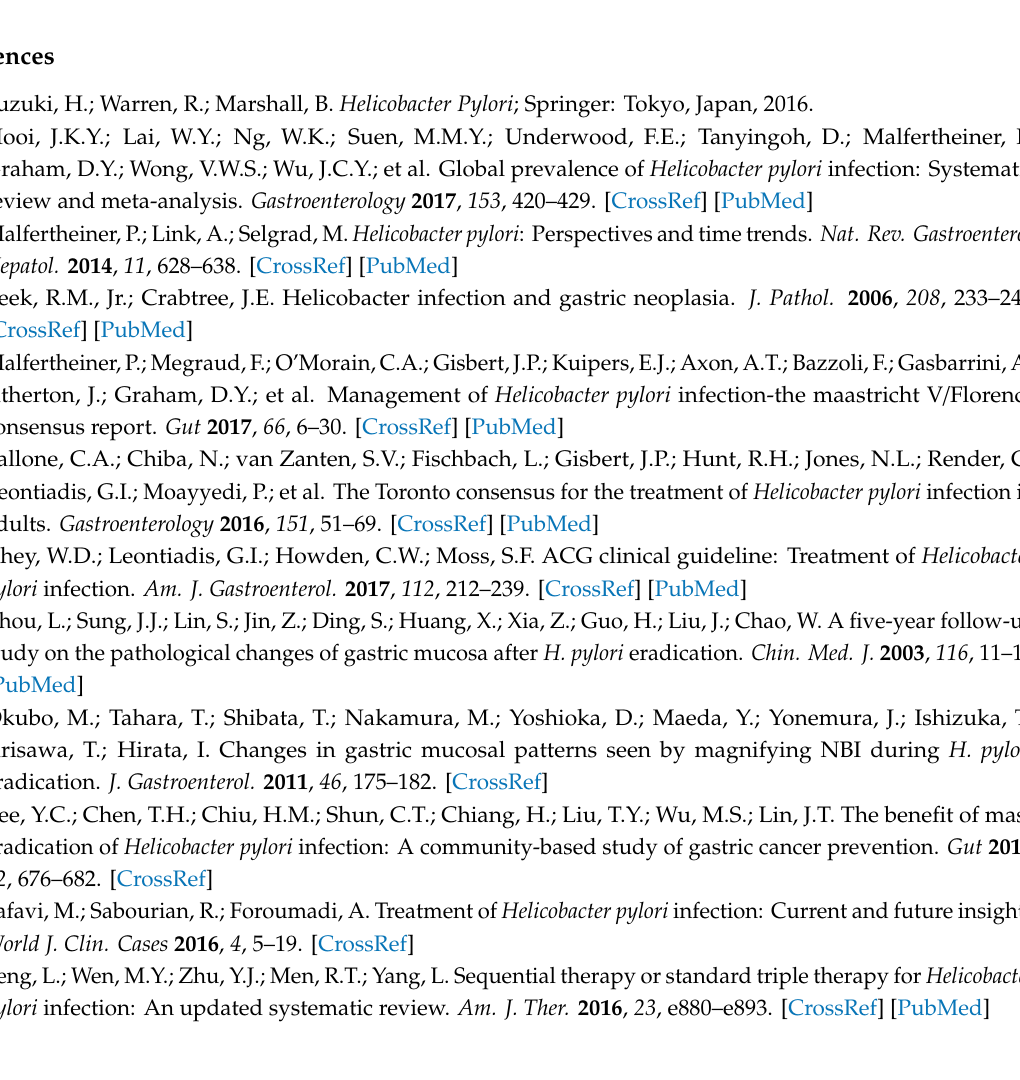
Table S1. The results of the statistical analysis of the selected